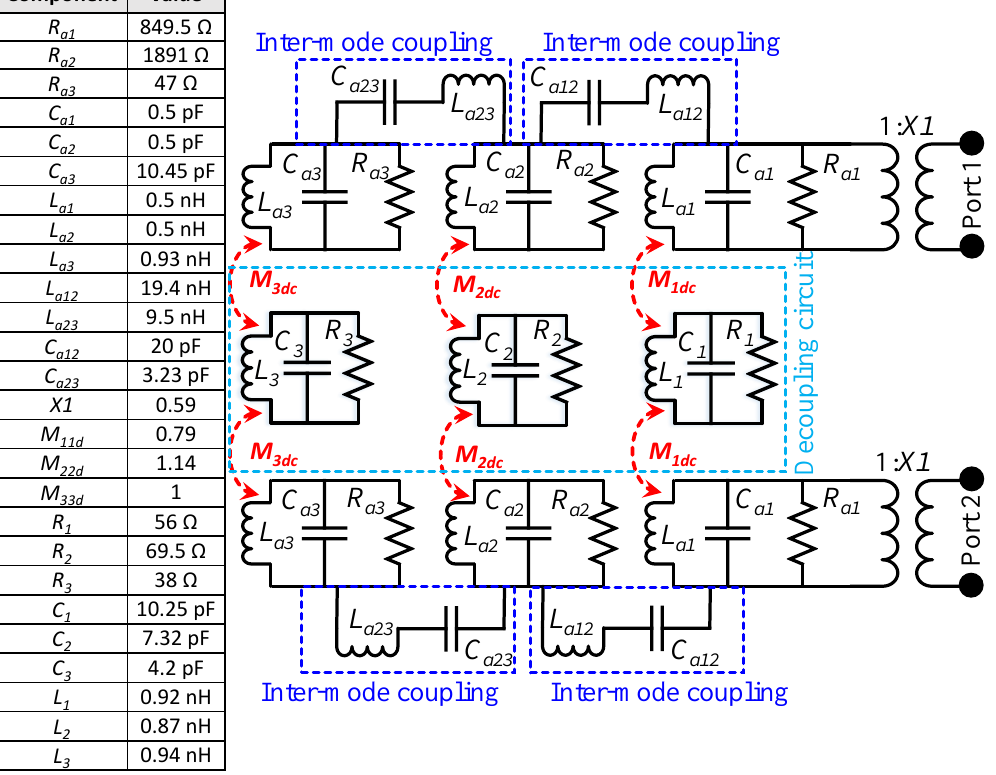
Figure 6. Lumped element equivalent circuit model of the UWB-MIMO system with decoupling